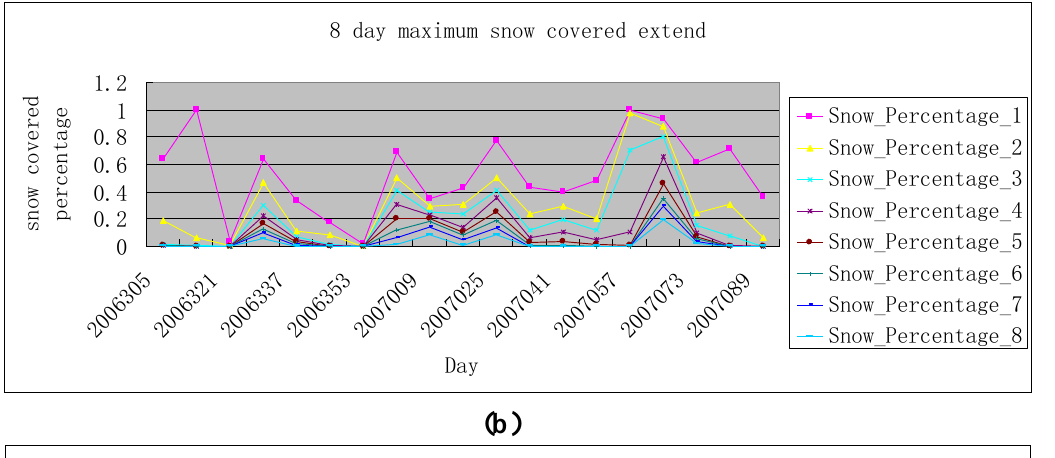
Figure 11. 8-day maximum snow cover extent mapping for (a) 2006–2007 and (b) 2007–2008. (a) 8 day maximum snow covered